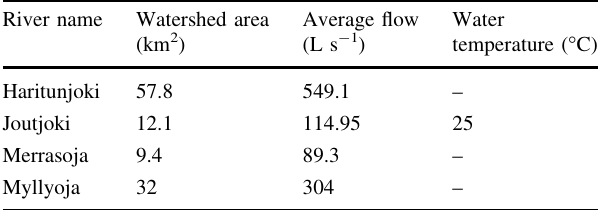
Table 1 The characteristics of rivers inflowing to the Enonselka¨ basin